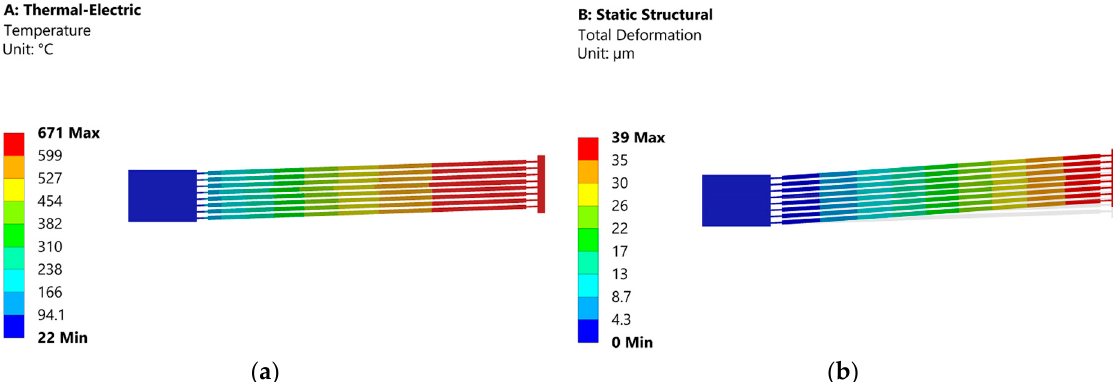
Figure 11. ( a ) Temperature field; ( b ) displacement field when the thermal actuator is biased with 6.2 V.